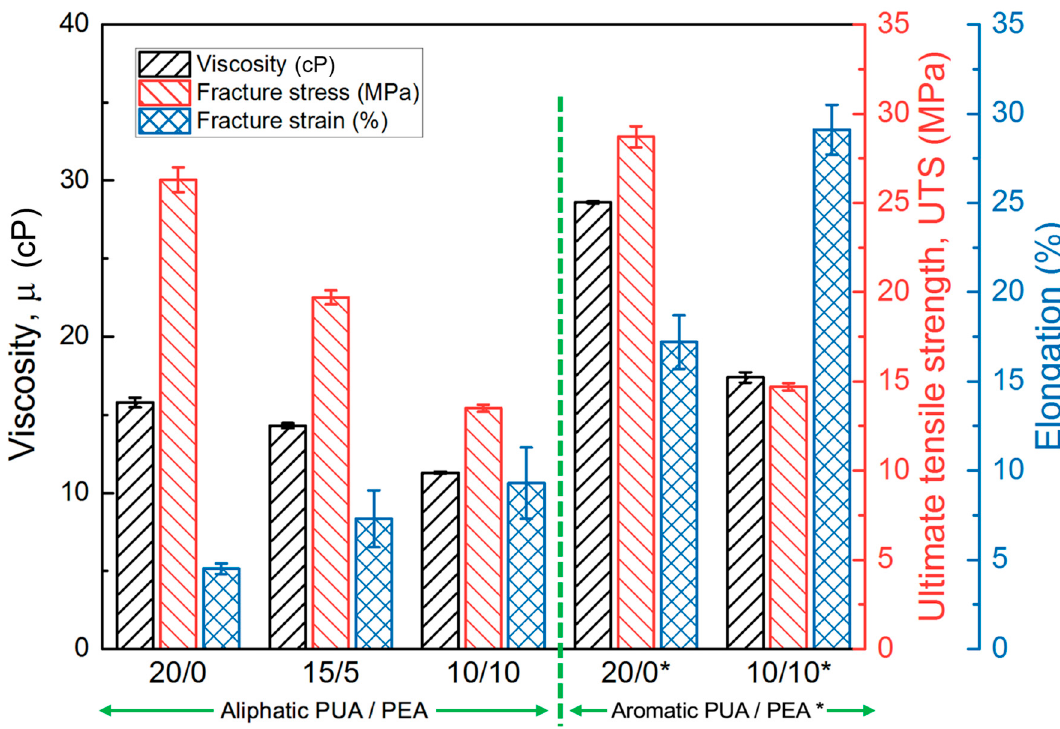
Figure 3. Comparisons of the physical and mechanical properties of the resins composed of di ff erent oligomers.